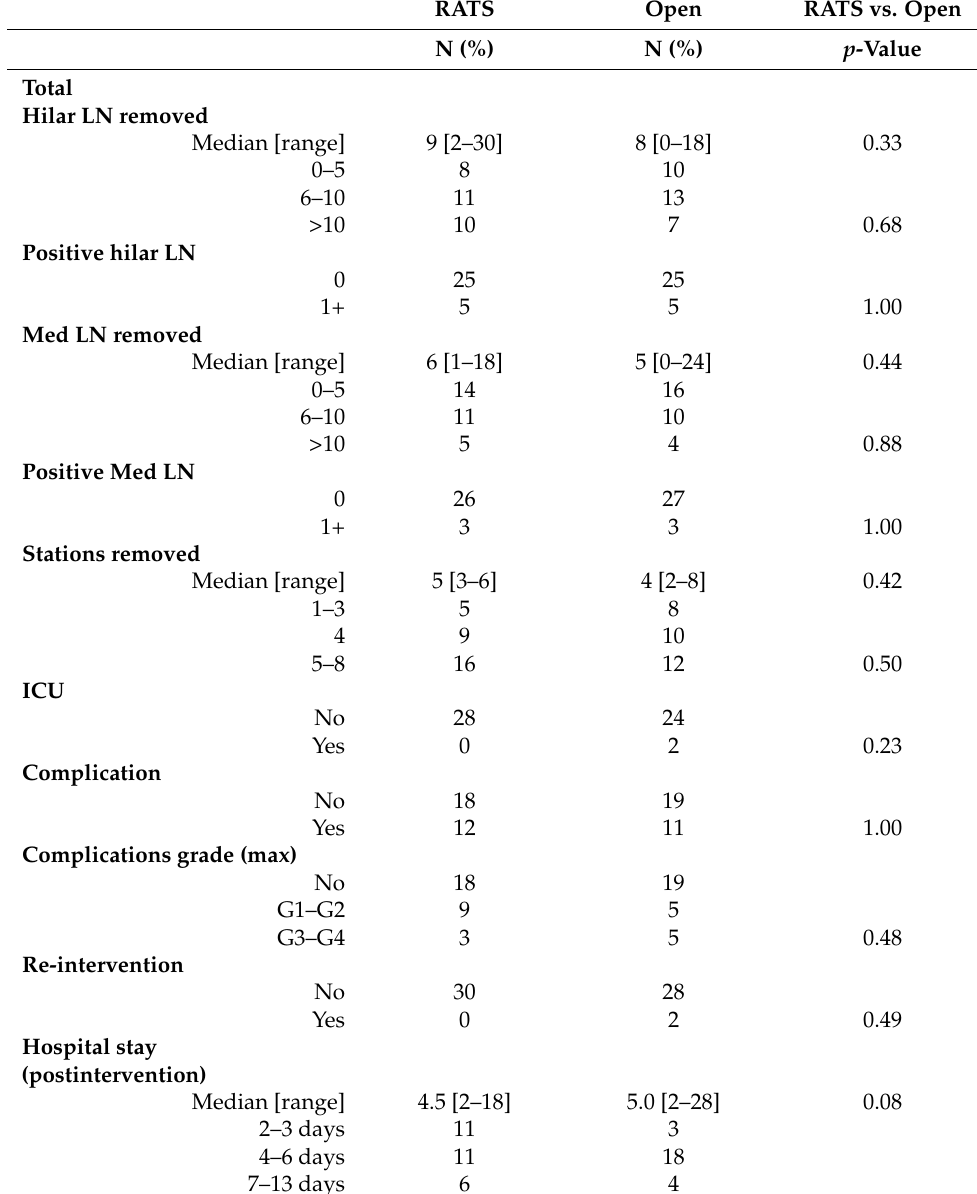
Table 4. Perioperative outcome and pathological results in the matched RATS and OPEN intervention groups. RATS Open RATS vs.